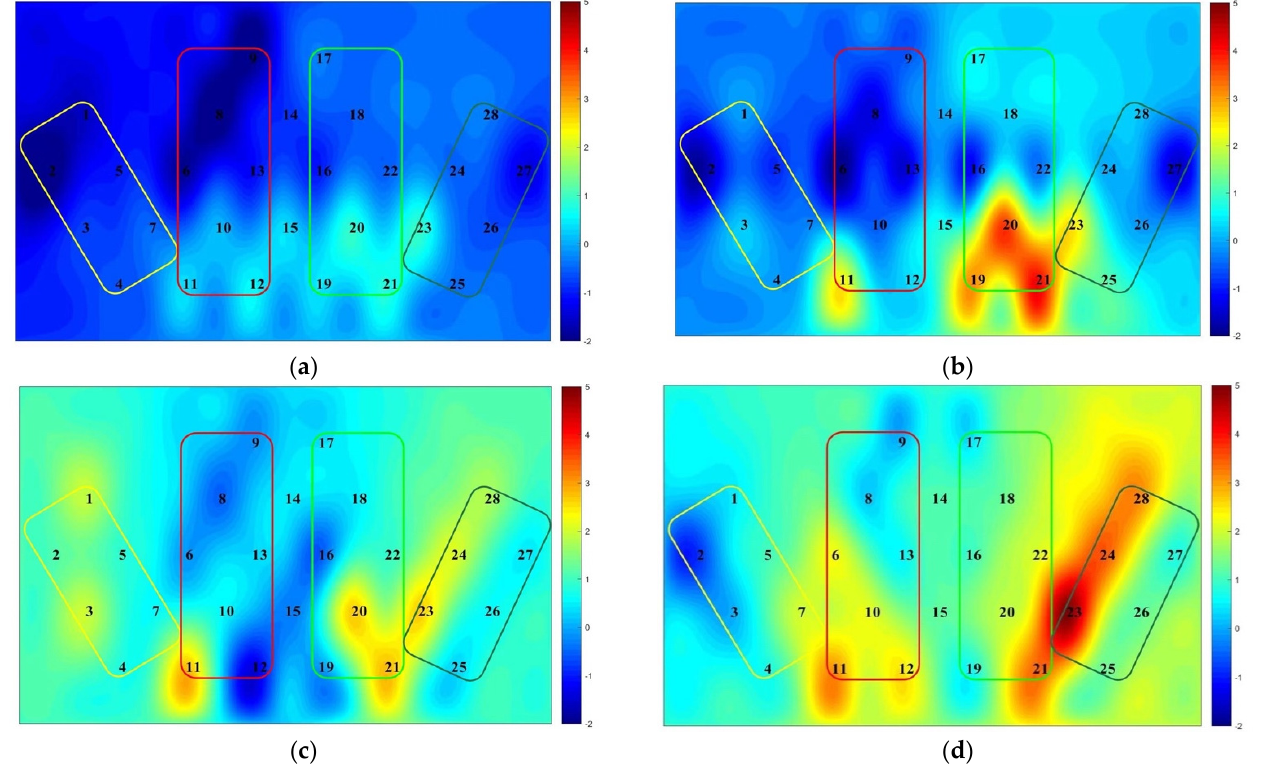
Figure 6. Results of fNIRS for the map-recognition spatial memory task. This figure depicts the activation level of brain regions at different maps (task difficulty) for the expert and novice groups. The more the colors are skewed toward warm colors (orange, red) the higher the activation level of the region, and the more the colors are skewed toward cool colors (blue, green) the lower the activation level of the region. Numbers represent different brain channels ( a ) Expert group simple map; ( b ) novice group simple map; ( c ) expert group complex map; ( d ) novice group complex map. The colored boxes from left to right in the picture represent different brain regions, yellow: L-VLPFC; red: L-DLPFC; grass green: R-DLPFC; olive green: R-VLPFC.